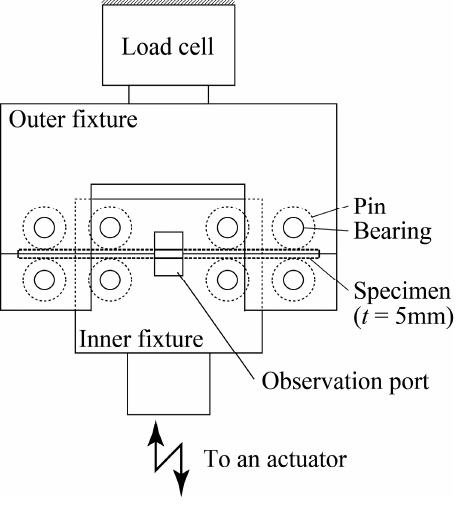
Figure 5. Schematic illustration of a four ‐ point bending jig for a specimen with a thickness of t = 5 mm.